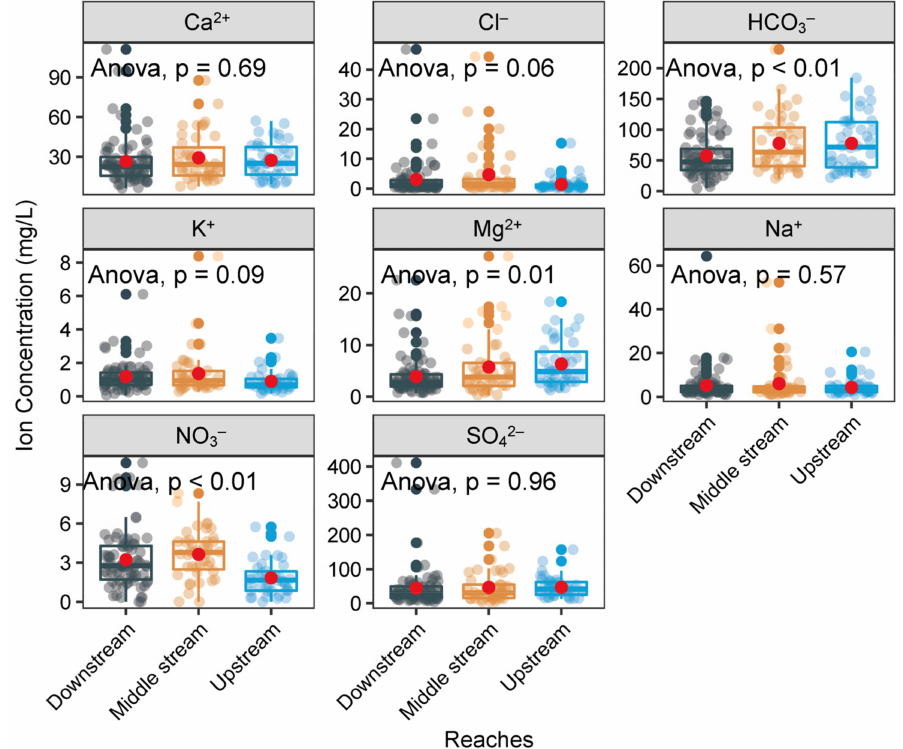
Figure 4. Boxplot of the concentrations of the major ions (in mg/L) for different reaches of the LR. One-way ANOVA analysis results for different ions are also shown in p